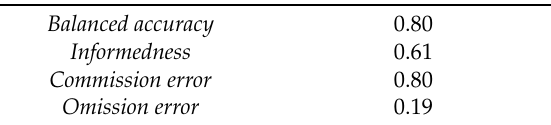
Table 1. Bias adjusted accuracy measures using visual interpretation of 446 stratified random samples equally distributed in the built-up and non-built-up areas.